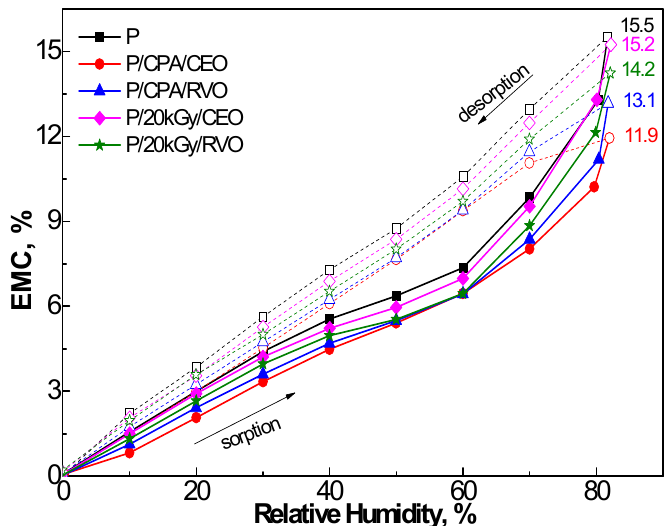
Figure 4. Sorption-desorption curves for analyzed samples.